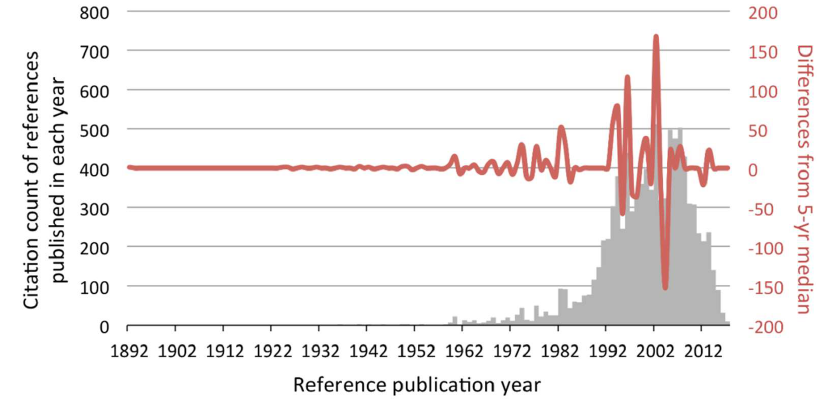
Figure 2. Reference publication year spectroscopy (RPYS) based on the references made by the 280 papers. Each bar (grey) represented the total citation count received by all references published in that particular year. The line (red) shows the difference in the annual citation count from its 5-year median. Take the largest positive peak (year 2002) as an example. References published in years 2000, 2001, 2002, 2003, and 2004 received 397, 344, 512, 318, and 323 citations, respectively. The 5-year median was 344. As references published in year 2002 received 512 citations, the difference was +168 and hence formed a large positive peak.